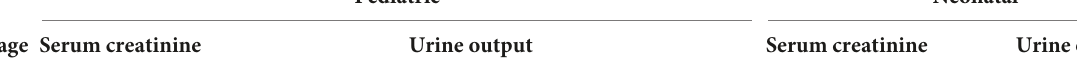
TABLE 1 Kidney disease: improving global outcomes (KDIGO) acute kidney injury (AKI) classification including neonatal modifications. Pediatric Stage Serum